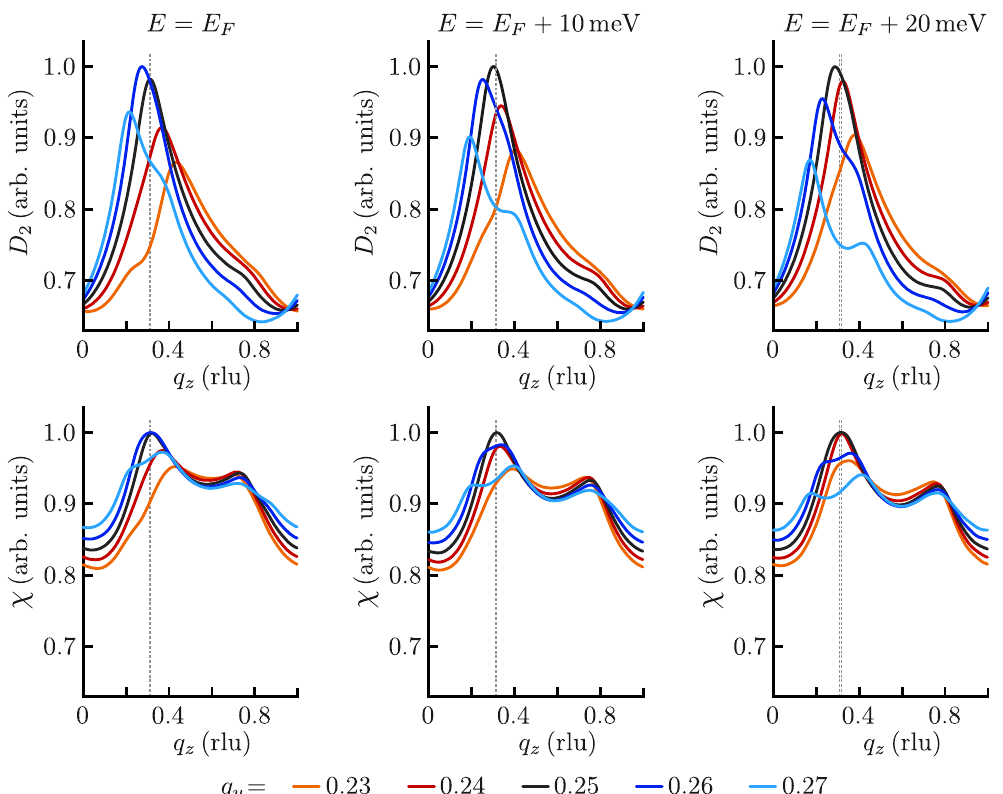
Figure 6: The structured susceptibility (top row) and Lindhard function (bottom row) along q , for various values of q , and varying the chemical potential. The two z y closely-spaced vertical dashed lines correspond to the two experimentally observed values of the out-of-plane component of the CDW wave vector [ 21 ] . Curves are normalised per panel.